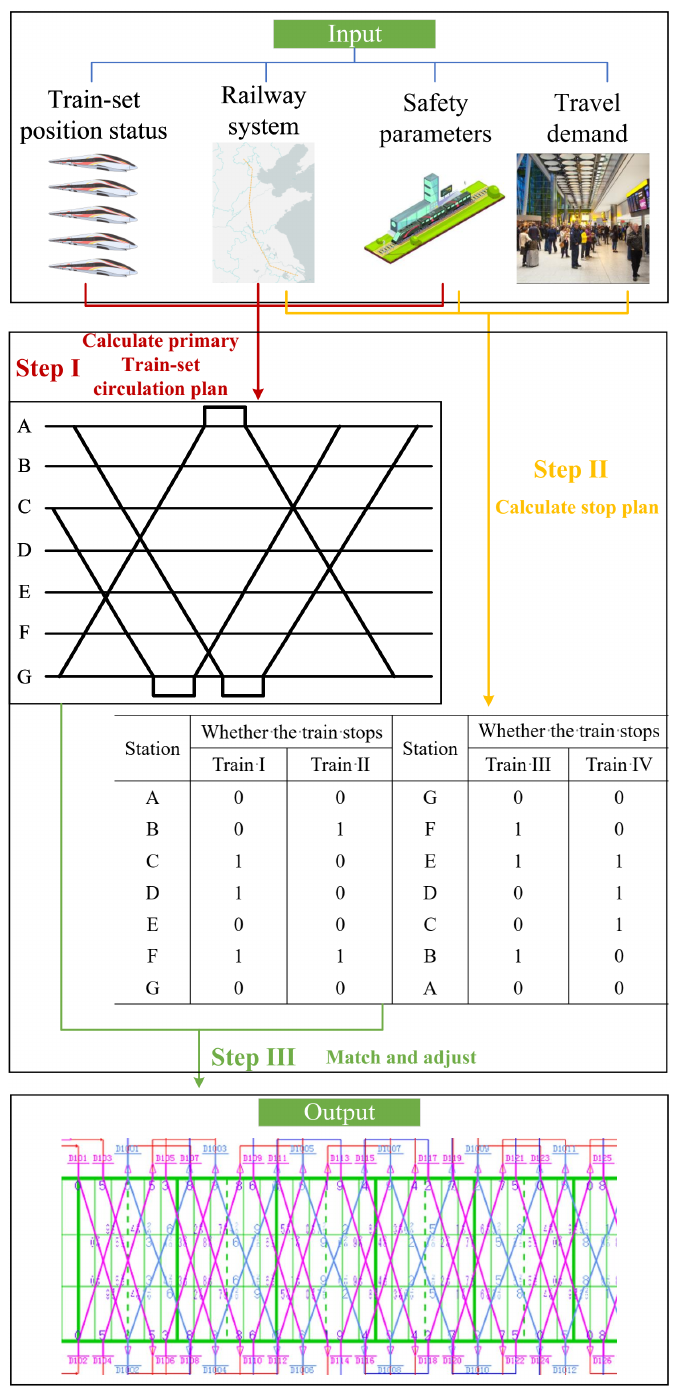
Figure 4. Framework of the